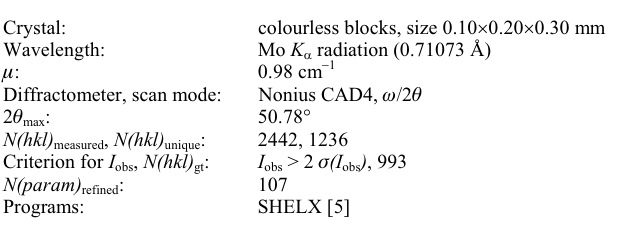
Table 1. Data collection and handling.